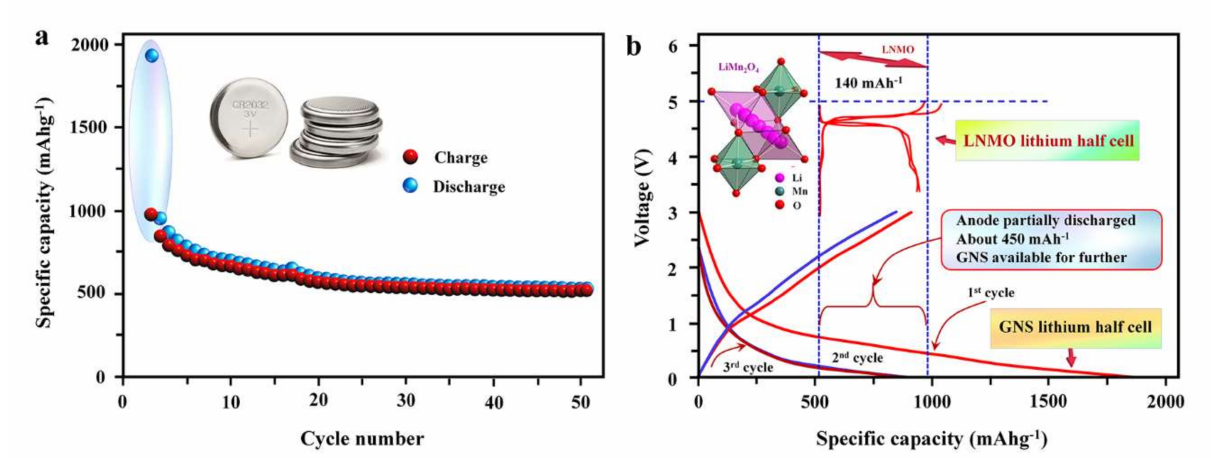
Figure 8. Cycling performance of GNS as anode; ( a ) charge–discharge profiles of GNS at 149 mA g − 1 , ( b ) charge/discharge profiles of the GNS resulting by the pre-cycling process at 74 mAh g − 1 in lithium and LNMO half cells. Adapted and reproduced with permission from [34]. Copyright 2013 Royal Society of